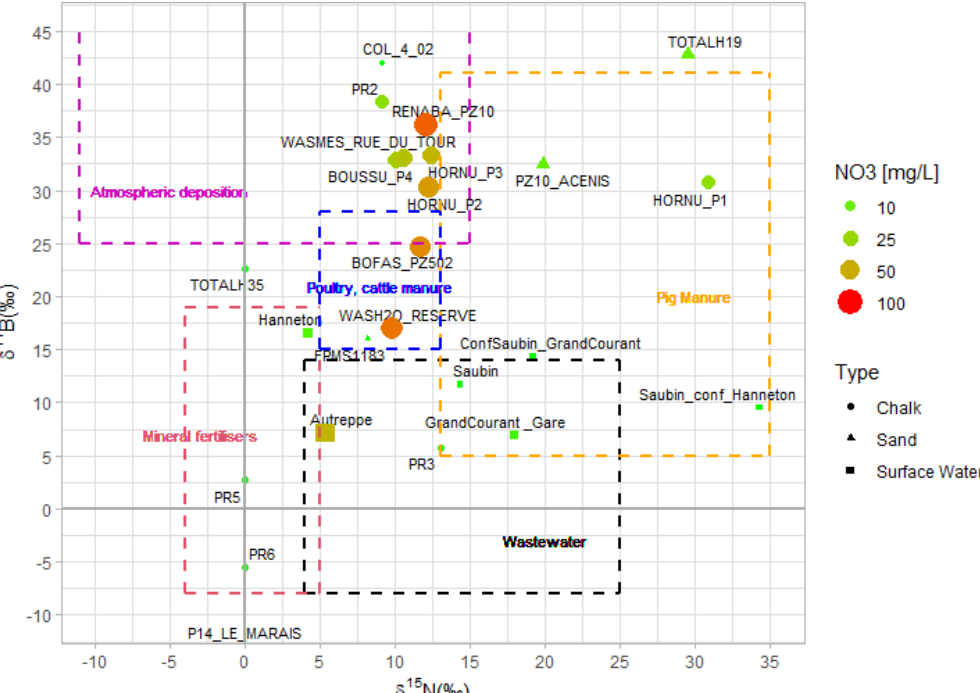
Figure 4. Stable isotopes of nitrate ( δ 15 N with a precision of ± 0 . 4‰) and boron ( δ 11 B ± 2 . 6‰): results of the Boussu site for Summer 2021 (very similar results obtained in Autumn 2020).